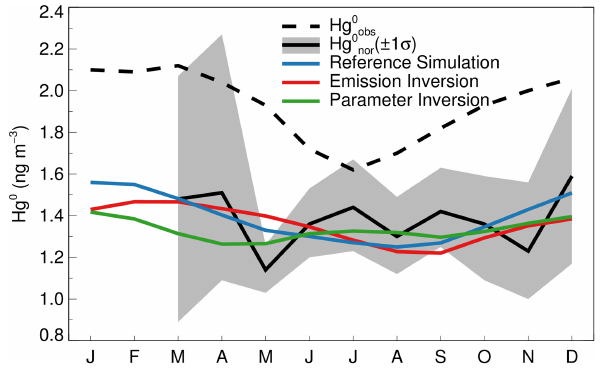
Figure 2. Observed and modeled monthly Hg 0 concentrations over the North Atlantic Ocean. The observational data and related refer- ences are given in the Supplement. Hg 0 are the concentrations ob- obs served from 19 ship cruises during 1990–2009, whereas Hg 0 nor are the concentrations normalized to levels consistent with year 2009. The gray shaded region shows the 1 σ error of Hg 0 nor , which is com- posed of the observational error, mismatch error, and regression er-